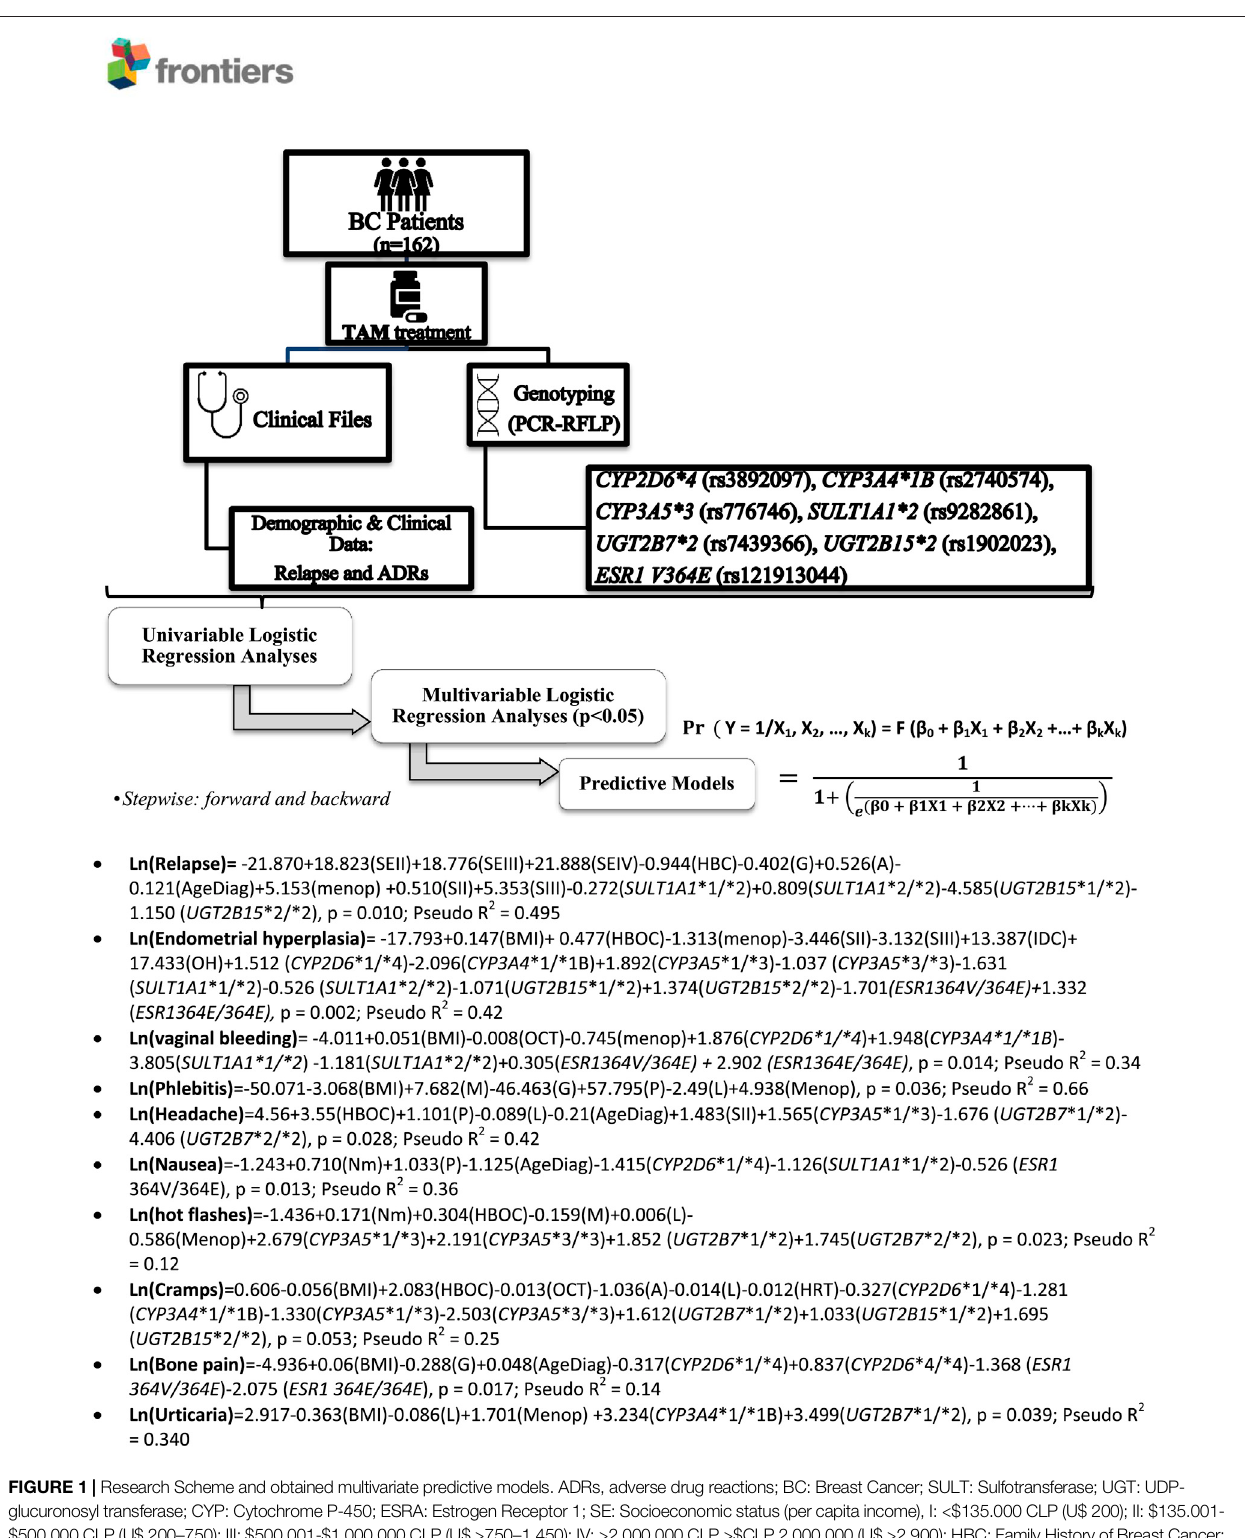
Frontiers in Pharmacology |